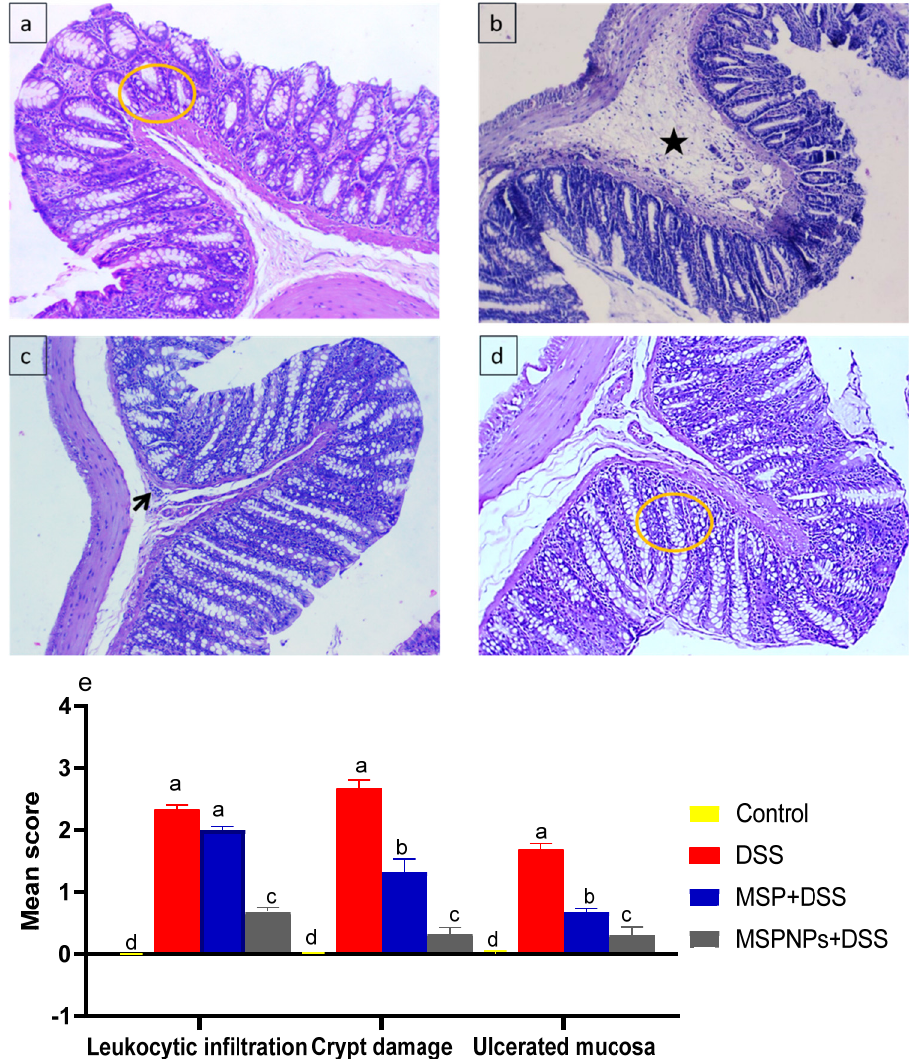
Figure 7. Histological changes following oral administration of multi-strain probiotics (MSPs) or multi-strain-probiotic-loaded nanoparticles (MSPNPs) in colitic rats. Non-colitic group: Control (rats were orally gavaged with PBS) ( a ) Colitic groups including: DSS (rats were orally gavaged with dextran sodium sulphate) ( b ) DSS + MSPs (rats were orally gavaged with DSS and multi-strains probiotics (MSPs) at the level of 1.0 × 10 10 CFU/kg in 1 mL of PBS/rat/day for 14 days) ( c ) DSS + MSPNPs (rats were orally gavaged with DSS and multi-strain-probiotic-loaded nanoparticles (MSPNPs) at the level of 1.0 × 10 10 CFU/kg in 1 mL of PBS/rat/day for 14 days) ( d ) all groups were orally gavaged with 5% DSS. Yellow circle: normal colon crypt structure. Arrowhead: ulcerated mucosa with abundant leukocytic infiltrations within lamina propria. Star: presence of serofibrinous exudate within submucosa. Scoring criteria ( e ) 0 = no; 1 = mild; 2 = moderate; and 3 = severe lesion. Scoring was performed blindly by an independent pathologist. a,b,c,d Means of the bars with different letters were significantly different among groups ( p < 0.05).